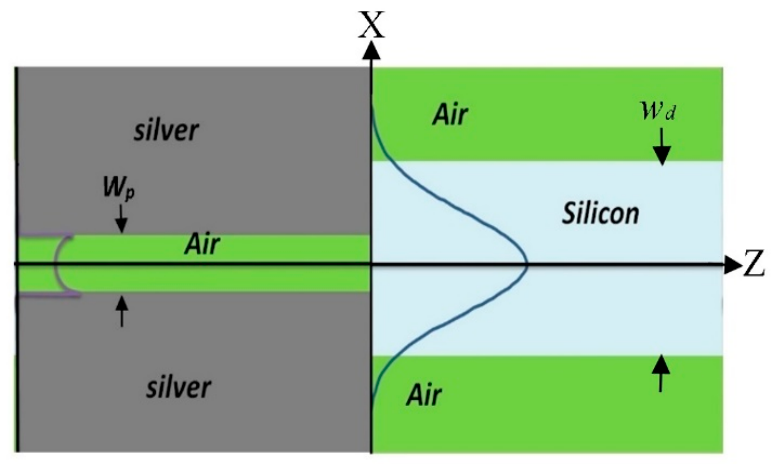
Figure 5. Butt-coupled metal-insulator-metal (MIM) and dielectric waveguides.